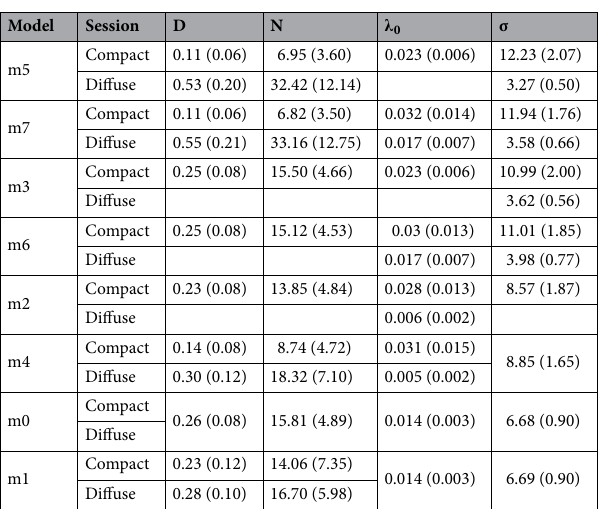
Table 3. Parameter estimates of SCR models tested on snow leopard data in Hunza-Nagar districts, Gilgit- Baltistan, Pakistan. D density/100 km 2 , Ν population, (cid:31) 0 detection probability, σ spatial scale parameter. Standard error is provided in parenthesis.